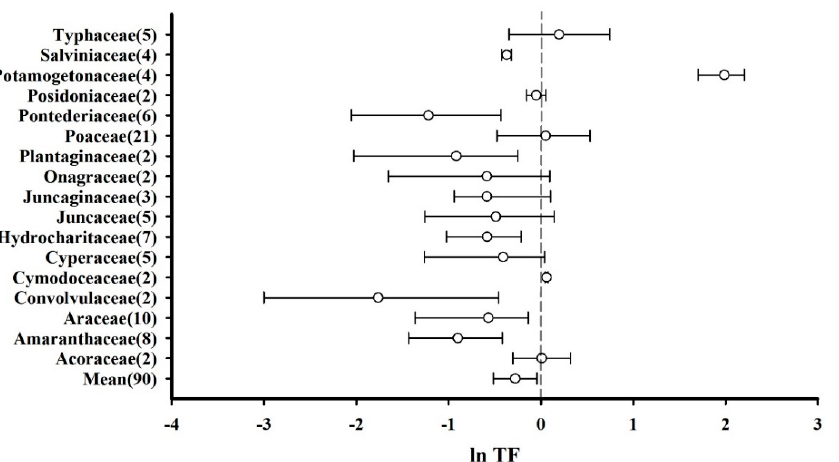
Figure 4. Translocation factors (TFs) of plants based on their families presented as the mean effect size and 95% CI. The numerals after the family names represent the number of observations. “Mean” indicates the overall effect considering all the plant families.